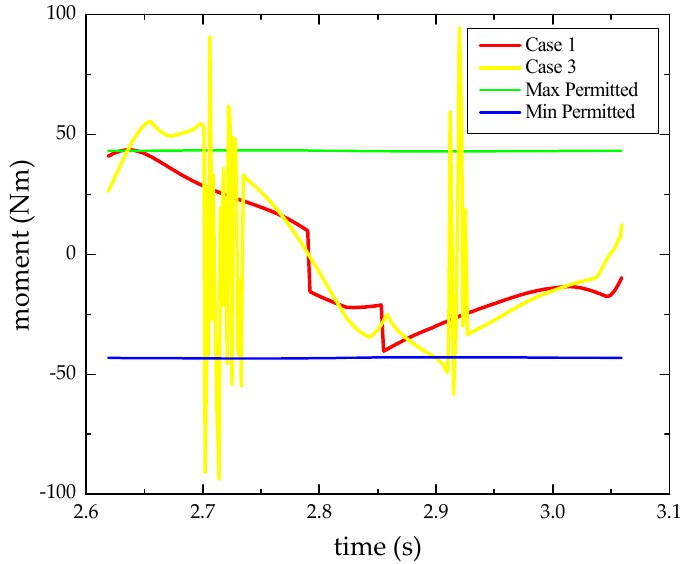
Figure 6. The moment between the left sole and ground in a single-support phase. The actual moments in Case 1 and Case 3 are measured by the six-dimensional F-T sensor.